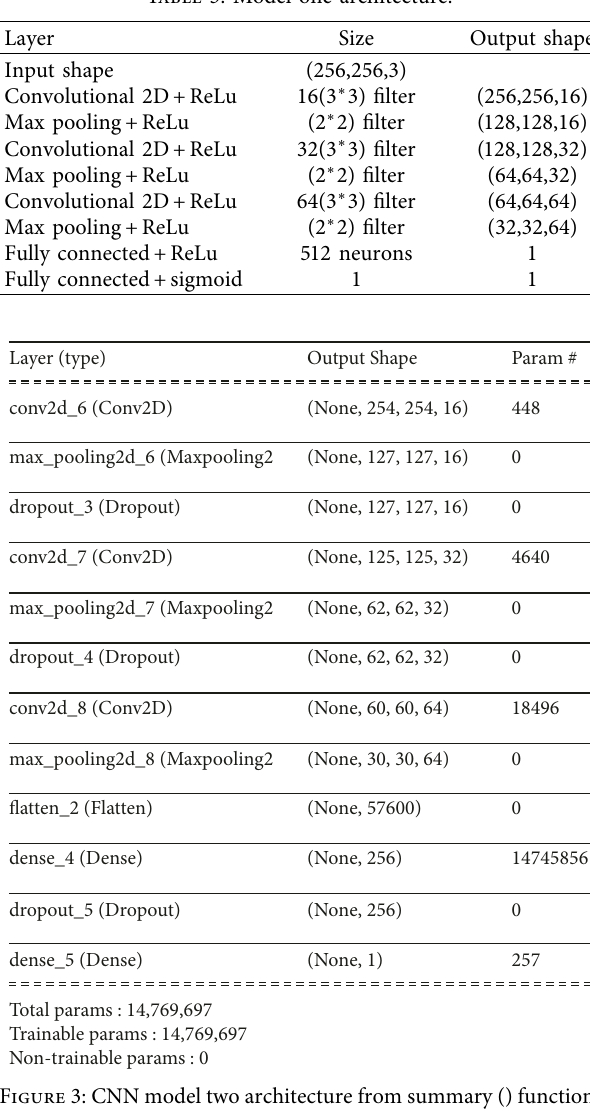
Table 3: Model one architecture.